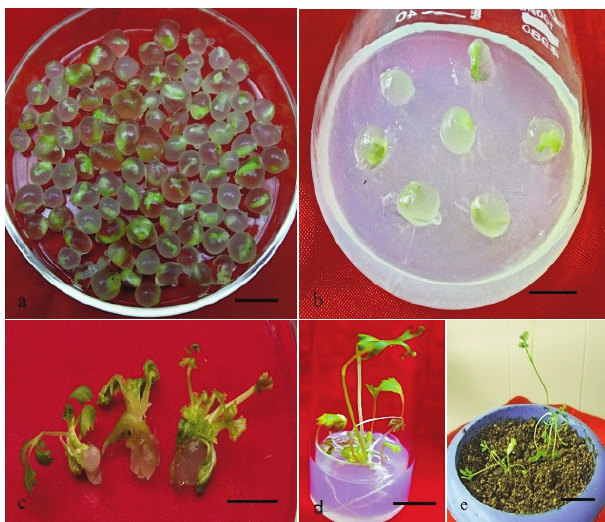
Fig. 3 - Synthetic seed development and plantlet formation in Coriandrum sativum (RS). a) Encapsulated somatic embryos; b) Synthetic seeds on the germination medium; c) Germinating synthetic seeds; d) Rooted plantlet and e) Synthetic seed derived plant, grown in outdoor condition (scale bar, a= 1.5 cm, b-d= 1 cm, e=2 cm).